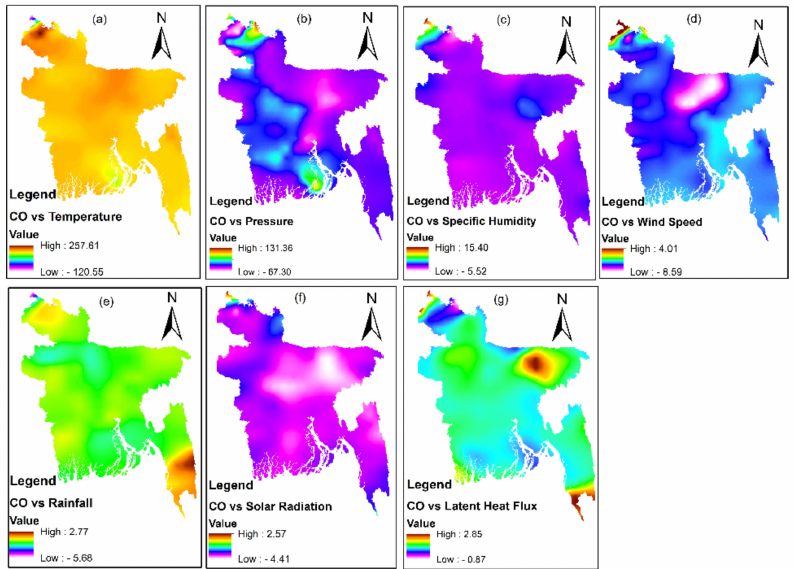
Figure 11. Spatial representation of the relationship between CO and meteorological variables using the geographically varying coefficients from GWR modelling over Bangladesh during 2015–2020: